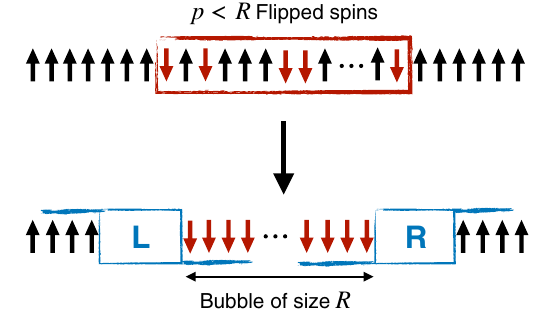
FIG. 10. Candidate low-order process leading to the meltdown of the order parameter. In the main text, we prove that the energy resonance between the two configurations is not possible under a generic assumption of strong incommensurability of the